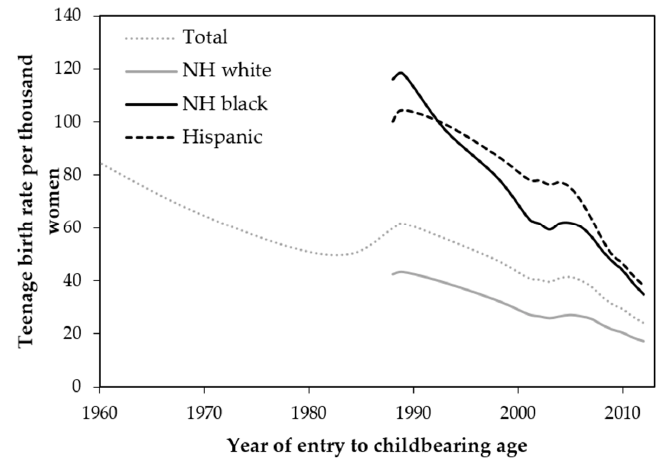
Figure 1. Birth rate for women 15 to 19 years old by year of entering into childbearing age and racial and ethnic group. Source: [5].